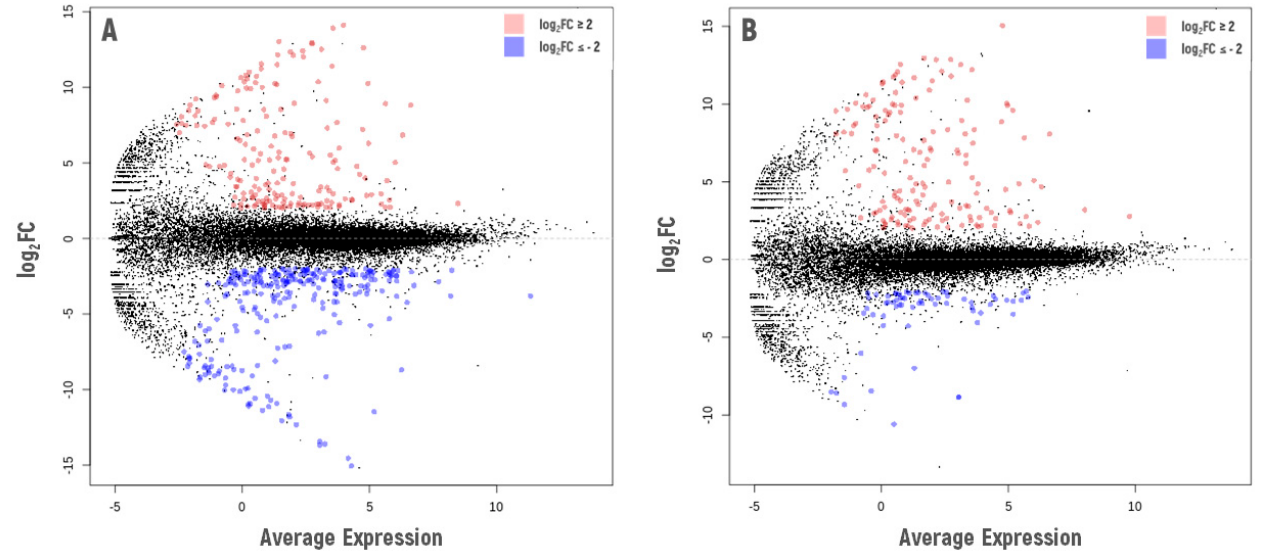
Figure 8. Overview of differential gene expression of 13-day-old A. thaliana seedlings recovering from chronic radiation exposure (( A ). VS-0, and ( B ). Masa-0) in comparison to the background reference accession Bab-0. Log 2 FC—logarithm of gene expression fold change. All plants were grown under control conditions, pooled leaf sample from a Petri dish was used as a biological replicate. Two replicates per condition were used for RNA sequencing. The graphs were created using the edgeR Package for RStudio v1.4 (R-Tools Technology, Richmond Hill, ON, Canada). Graphical changes were made with Microsoft PowerPoint 2019 (Microsoft Corporation, Albuquerque, NM, USA). Table 3. Set of enriched GO terms in the chronically irradiated A. thaliana natural accessions VS-0 and Masa-0 in comparison with the reference accession Bab-0.